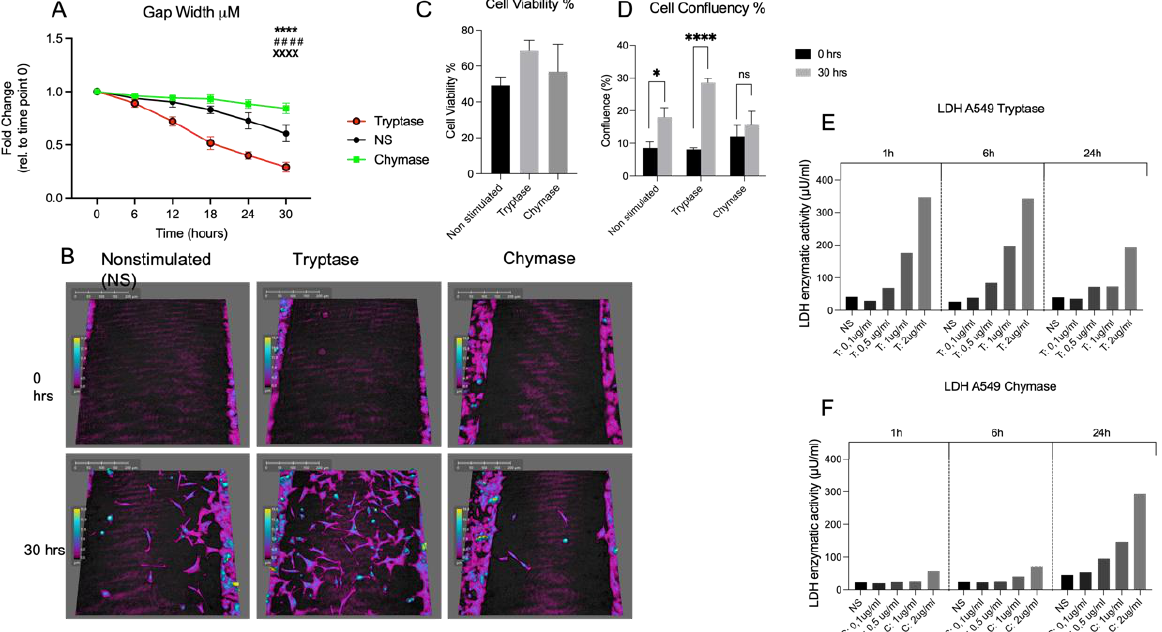
Figure 1. Tryptase enhances gap closure capacity whereas chymase attenuates the gap closure rate compared to nontreated cells in alveolar epithelial cells ( A ). Holographic images of non-stimulated, tryptase and chymase stimulated cells at 0 h and 30 h ( B ). Cell viability ( C ) and cell confluency test ( D ) to further evaluate potential cytotoxic effect of MC proteases. Lactate Dehydrogenase (LDH) cytotoxicity test establishes non-toxic working concentration of tryptase ( E ) and chymase ( F ) in al-